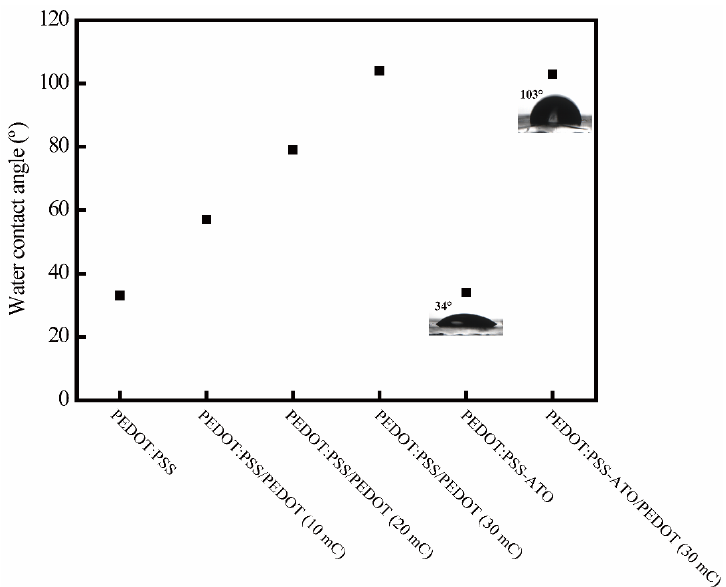
Figure 3. Water contact angles of PEDOT-based films and (inset) images of a droplet on the surface of PEDOT:PSS-ATO and PEDOT:PSS-ATO/PEDOT films.